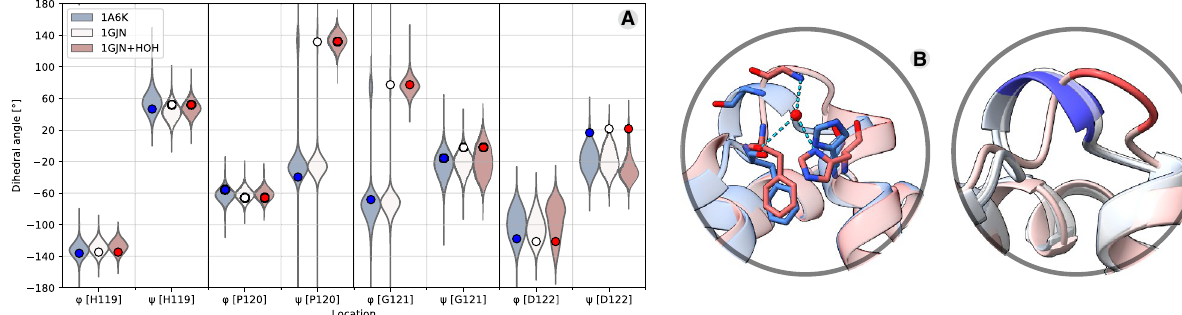
Figure 2. The horse heart turn conformation is associated with the presence of a structural water molecule. A display of dihedral angle distributions from 1us molecular dynamics simulations (violins) and initial values in PDB structures (circles) show that Eq_ myoglobin (white) adopts the Phy_ myoglobin (blue) turn conformation unless a structural water is maintained with the Eq_ myoglobin (red) ( A ). This structural water forms three hydrogen bonds in the the Eq_ myoglobin structure but not the Phy_ myoglobin structure despite the presence of the same amino acid network ( B ). AlphaFold predicts Phy_ myoglobin conformation from Eq_ myoglobin sequence (grey cartoon, aligned to Eq_ myoglobin 1GJN (red) and Phy_ myoglobin 1A6K (blue)) ( C